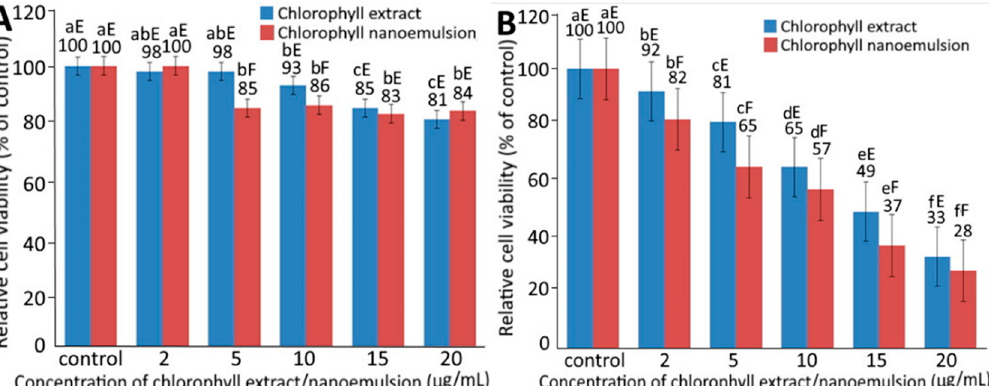
Figure 4. Effect of different concentrations of chlorophyll extract and nanoemulsion on growth of fibroblast cells CCD986SK ( A ) and human melanoma cells A375 ( B ). For control, cells were incubated in medium containing 1% DMSO. Data represent mean ± standard deviation ( n = 3) with different small letters (a–f) within the same treatment for different concentrations as well as different capital letters (E–F) within the same concentration for different treatments indicating significantly different values at p < 0.05.